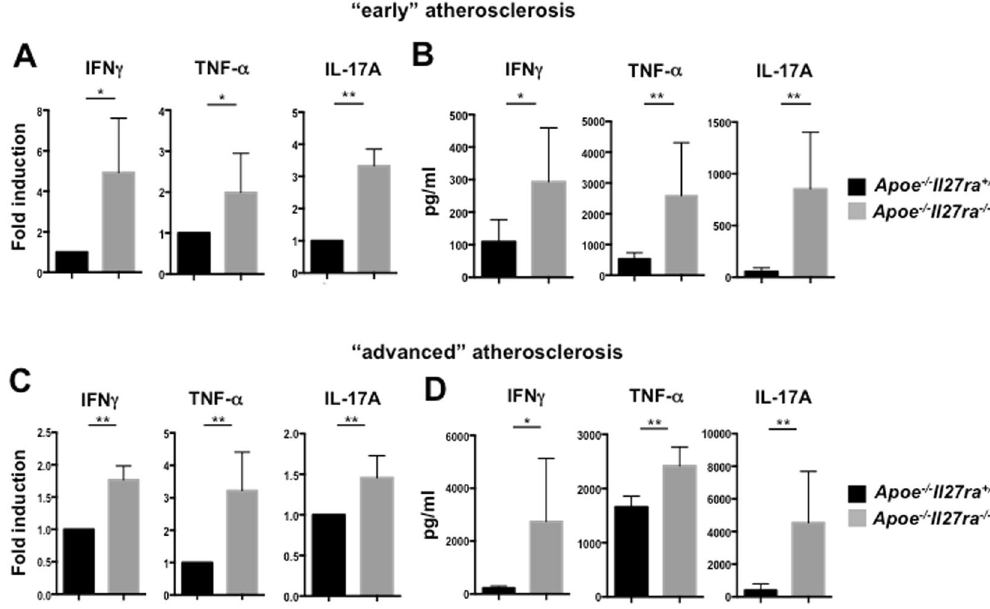
Figure 6. Increased expression of pro-inflammatory cytokines in aortas of Apoe − / − Il27ra − / − mice. ( A , C ) Relative gene expression of IFN γ , TNF- α and IL-17A in aortas of Apoe − / − Il27ra − / − (n = 5) mice fed with WD for 7 weeks ( A ) or 18 weeks ( C ) were normalized to L-32 gene expression and fold induction was calculated based on the gene expression in aortas of control Apoe − / − Il27ra + / − (n = 5). ( B , D ) Production of pro-inflammatory cytokines IFN γ , TNF- α and IL-17A in aortas of Apoe − / − Il27ra + / − or Apoe − / − Il27ra − / − mice at different stages of atherosclerosis was measured by multiplex cytokines array in supernatants of aortic cell suspension obtained from Apoe − / − Il27ra + / − (n = 5) or Apoe − / − Il27ra − / − (n = 5) mice fed with WD for 7 ( B ) or 18 weeks ( D ), stimulated with anti-CD3/anti-CD28 for 48 hours. Data are mean ± SEM from 3 independent